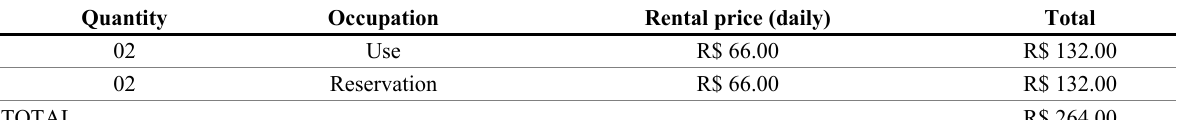
Table 9. Spending with